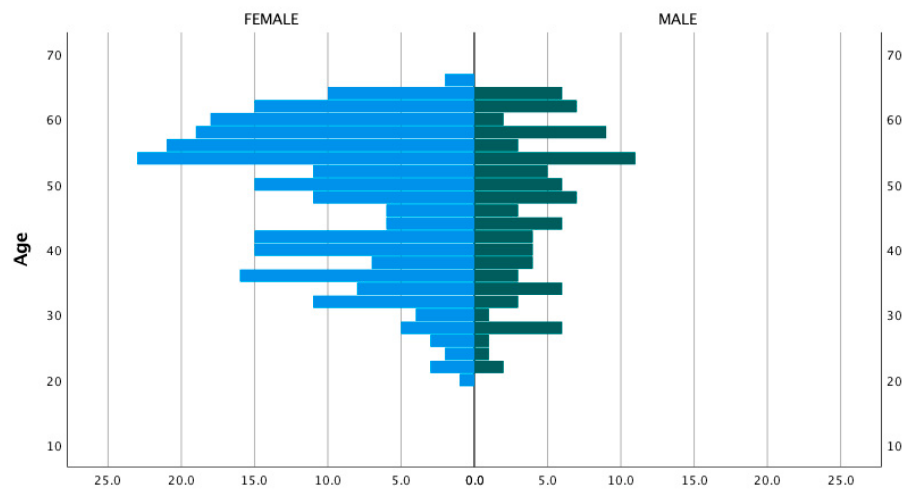
Figure A1. Population pyramid of the sample.